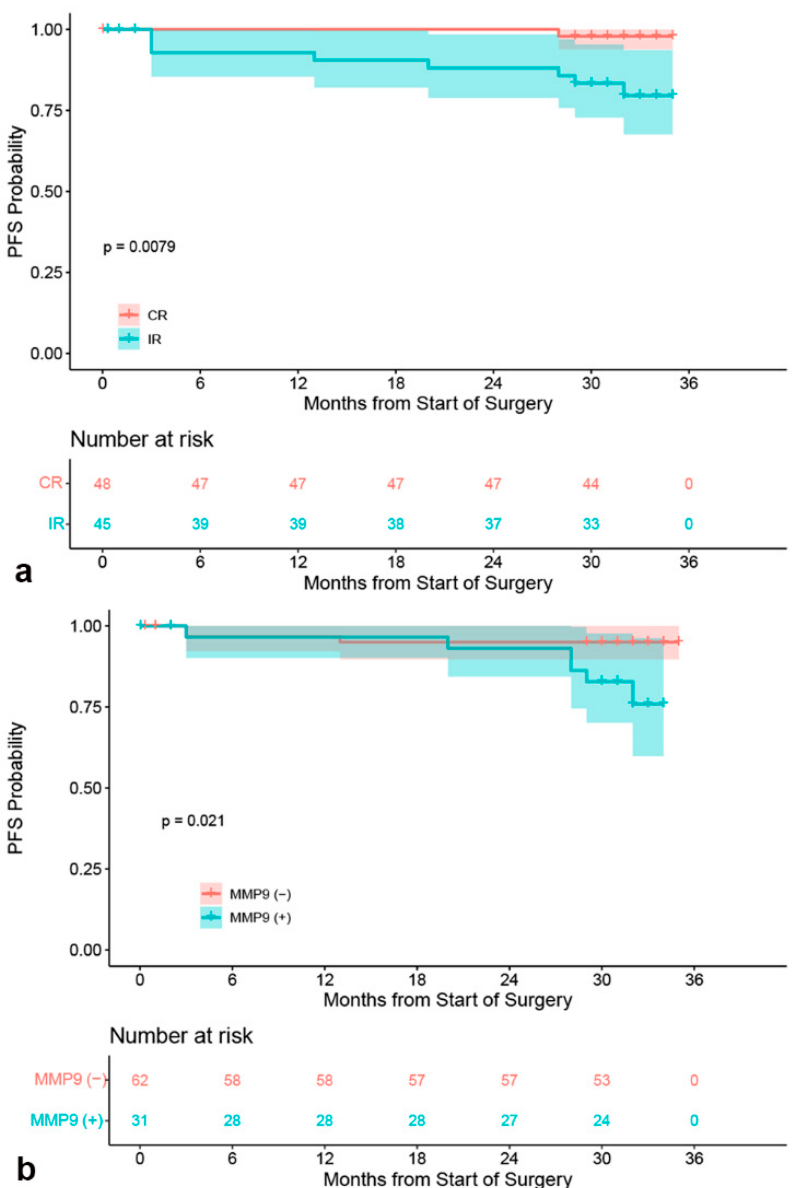
Figure 6. Kaplan–Meier PFS curves. PFS curve and PFS stratification based on complete resection (CR) and incomplete resection (IR) ( a ); PFS differed significantly between the MMP-9 positive and MMP-9 negative groups ( b ). Table 2. Univariate and Multivariate Cox Regression Analysis for Survival.